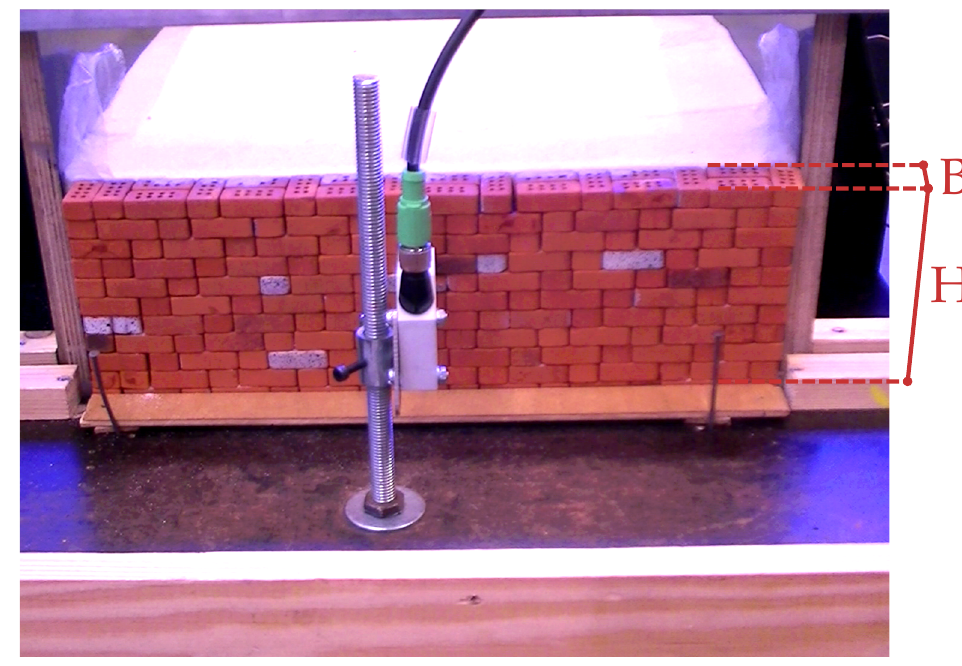
Figure 2. Retaining wall mock-up [33], for a wall of slenderness H/B = 3.3.